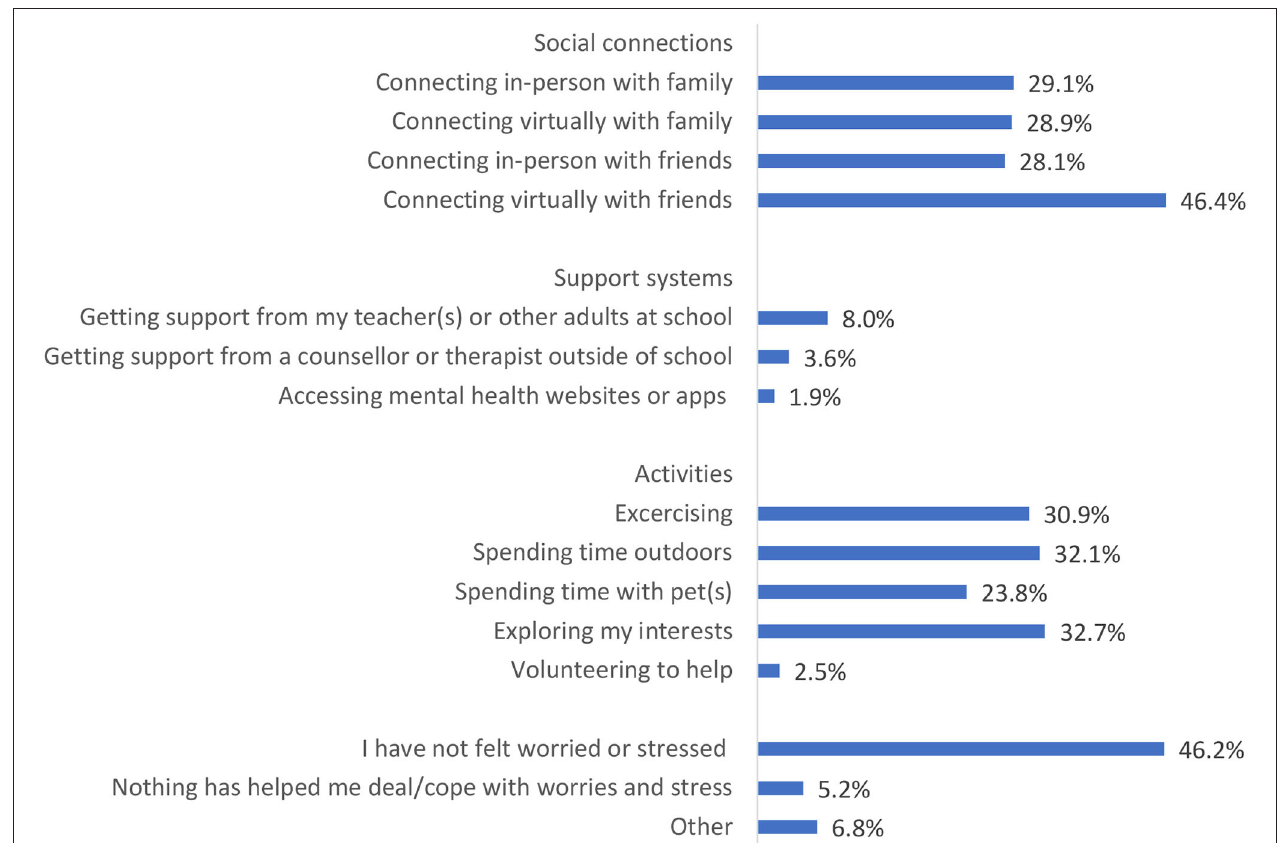
FIGURE 5 | Strategies that helped students cope with worries and stress related to the pandemic in the past 2